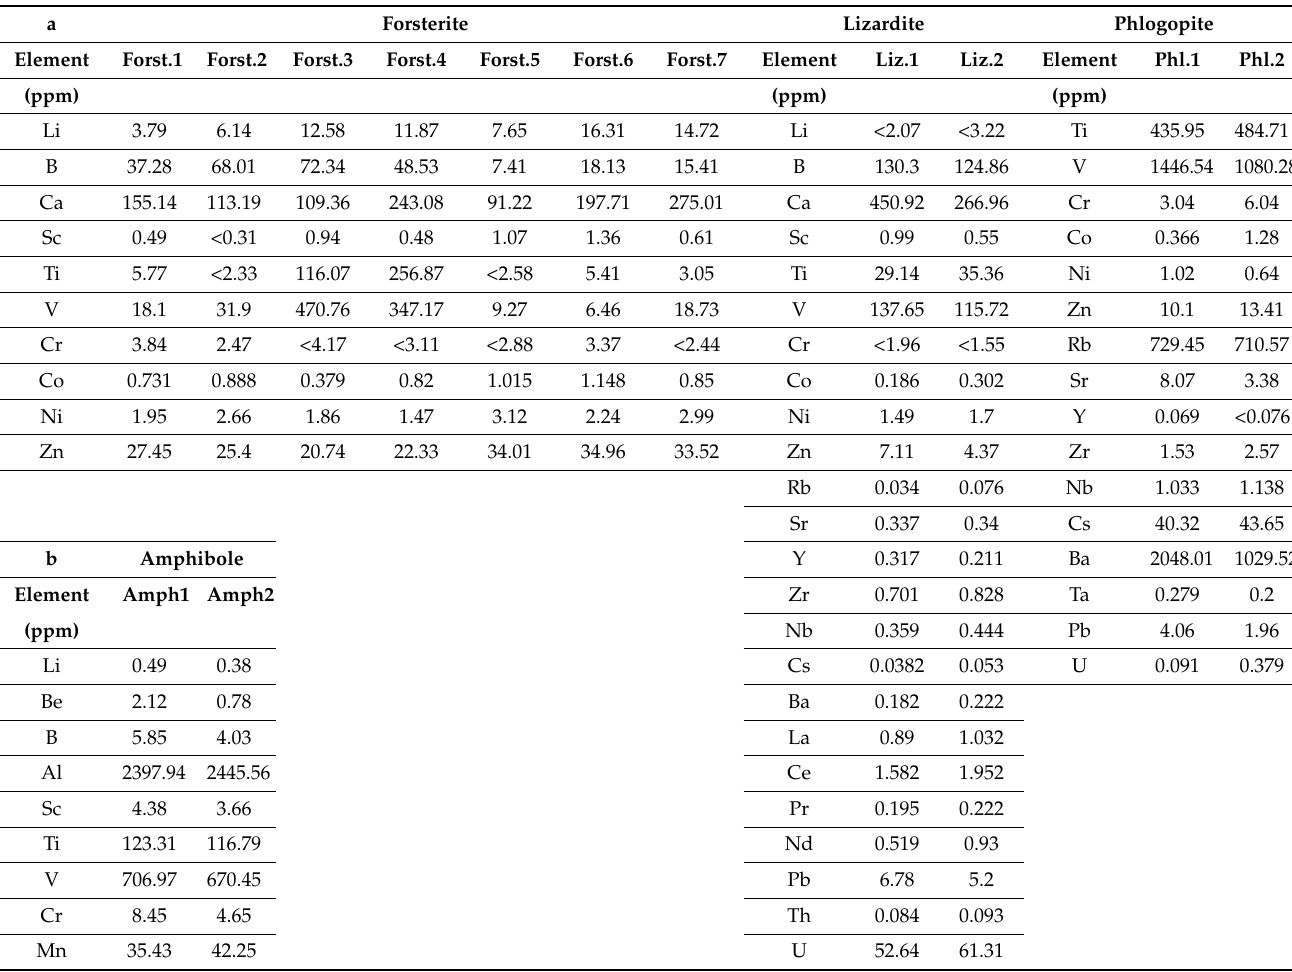
Table 2. LA-ICP-MS investigations on minerals associated with diopside from the right (Table a) and left side (Table b) of the Sissone valley.